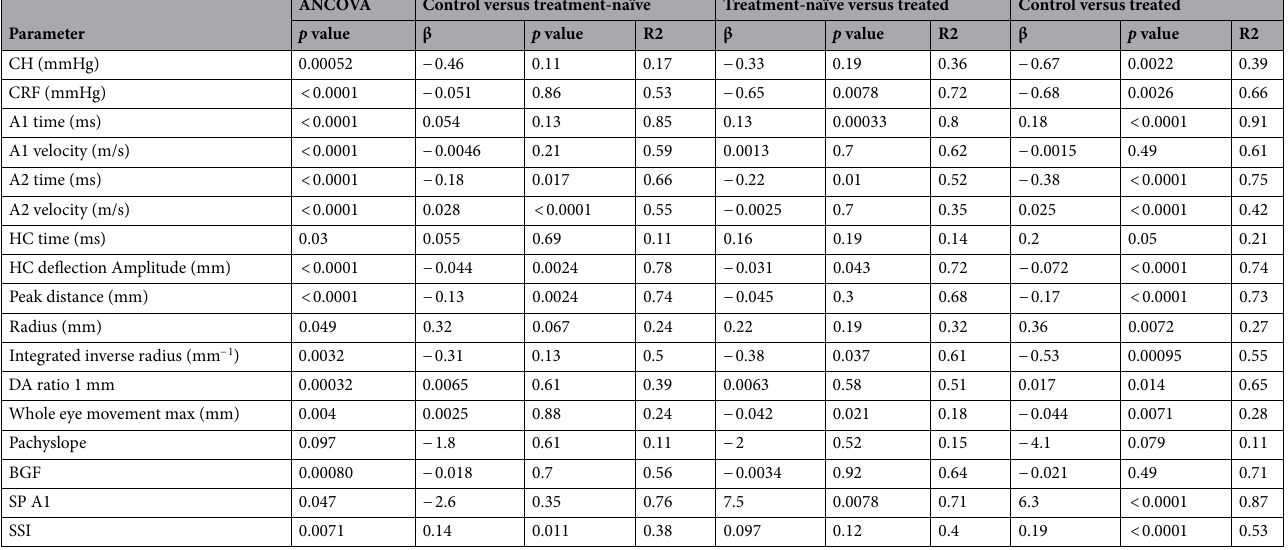
Table 4. Comparisons of biomechanical parameters measured with ORA and Corvis ST. Differences among three groups were tested by analysis of covariance; Differences between two groups from three groups were tested with a linear multiple regression model adjusted for bIOP, central corneal thickness, and axial length. BGF biomechanical glaucoma factor; bIOP biomechanical intraocular pressure; CH corneal hysteresis; CRF corneal resistance factor; DA deformation amplitude; HC highest concavity; SP A1 stiffness parameter applanation 1; SSI stress–strain index.